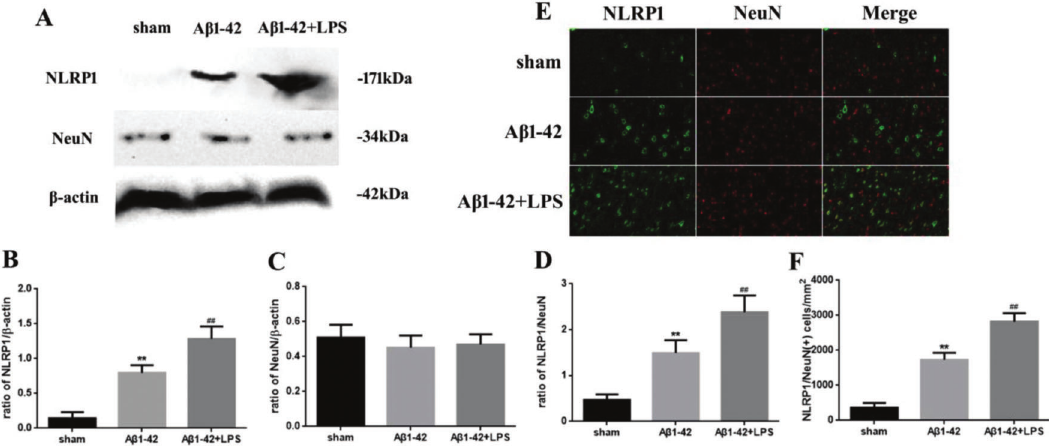
Figure 1 - (A) Western blotting assay for detecting the expression of NLRP1 and NeuN. (B, C) Quantification of the expression of NLRP1 and NeuN. (D) NLRP1/NeuN ratio. (E) Immunofluorescence assay for detecting the expression of NLRP1 and NeuN ( (cid:3) 400) and (F) NLRP1/ NeuN ( + ) cells in samples from the sham, A b 1-42, and A b 1-42 + LPS groups. Protein levels were normalized to those of b -actin (A b 1-42 vs . sham group, ** p o 0.05; A b 1-42 + LPS vs . A b 1-4 group, ## p o 0.05, n=6 per group. All data were represented as the mean ± standard